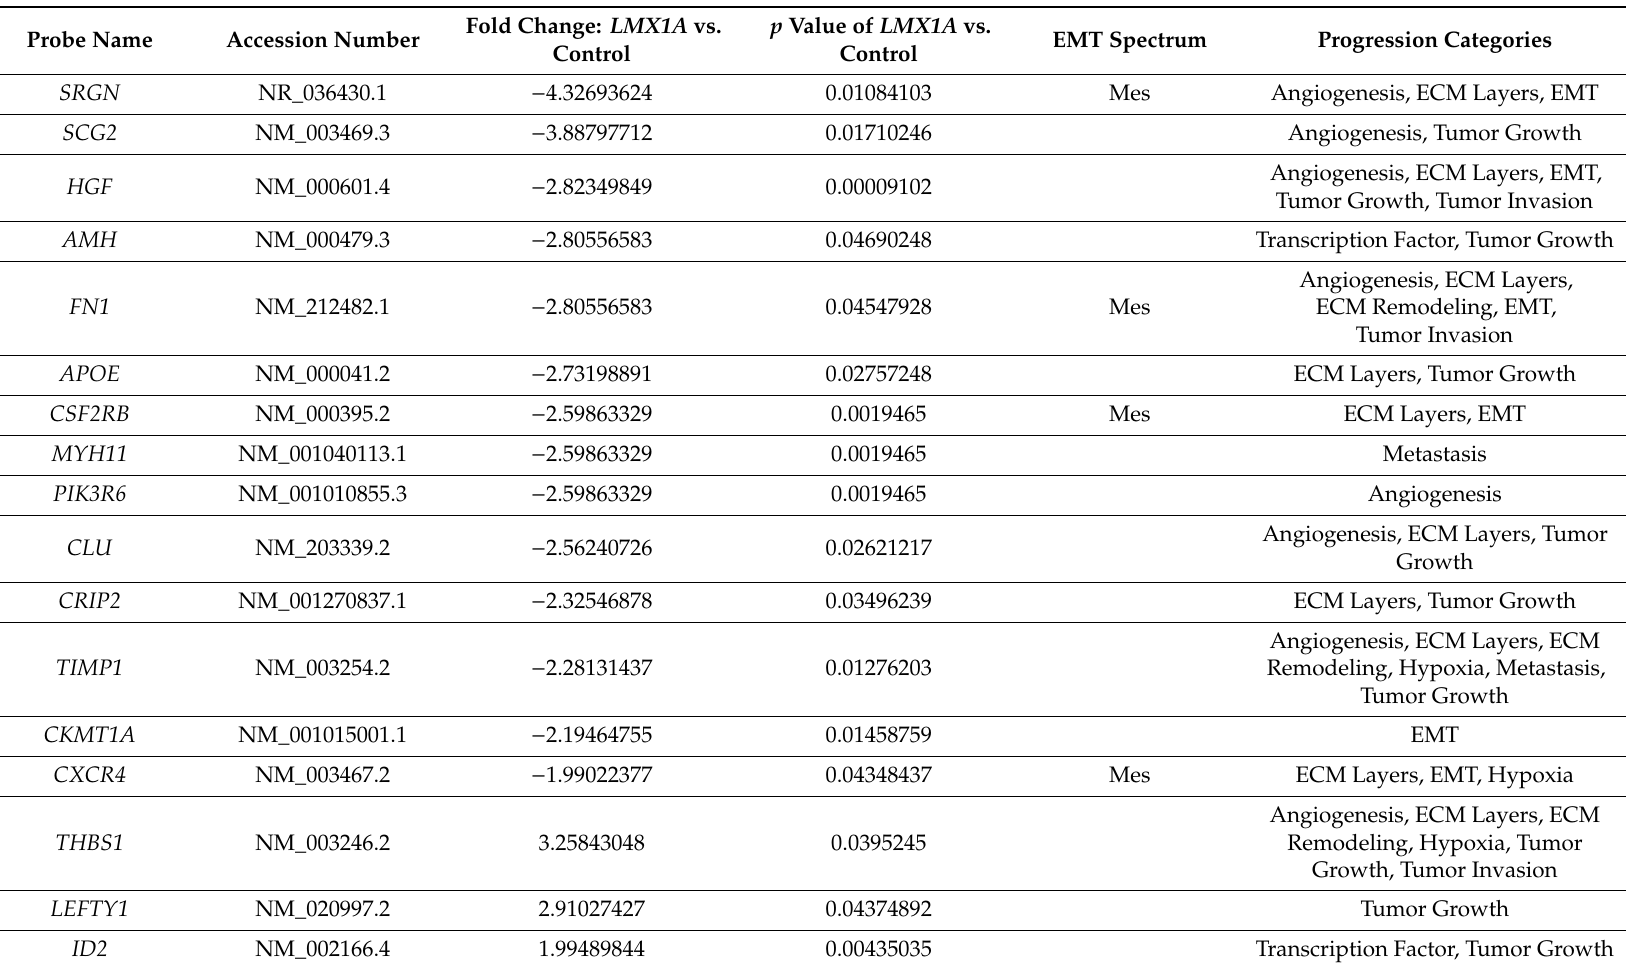
Table 1. Summary of di ff erentially expressed genes in the LMX1A-V5 H23 cell line by NanoString gene expression